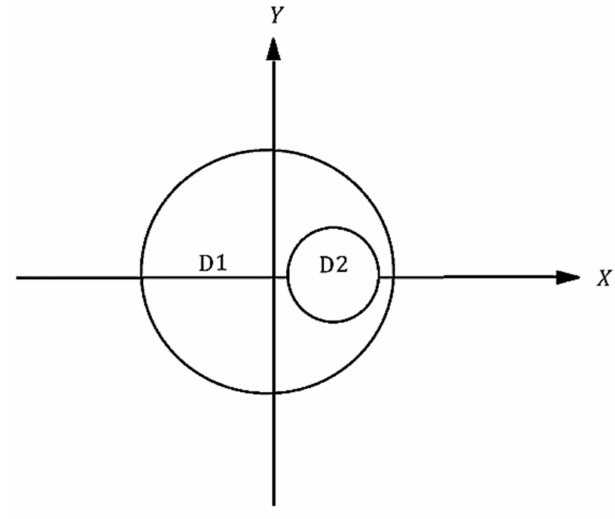
Figure 4. Schematic figure of domains 1 and 2 in tube cross-section.